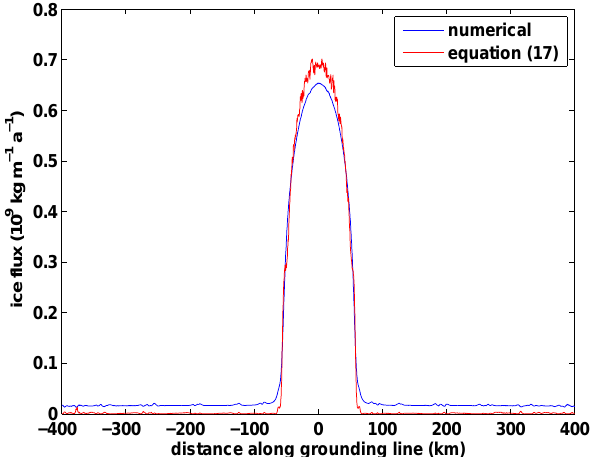
Fig. 6. The normal buttressing ratio 2 N where the medial line ( y = 0) crosses the grounding line as a function of ice thickness. As in Fig. 5 each data point is calculated for a different model setup with varying half-widths values, ( w c , see Eqs. 22 to 24) from 20 to 70km. The normal buttressing ratio is defined by Eq. (13) and reflects the difference in stress, or more precisely the difference in the normal component of the normal stress vector, at the grounding line in the presence and in the absence of an ice